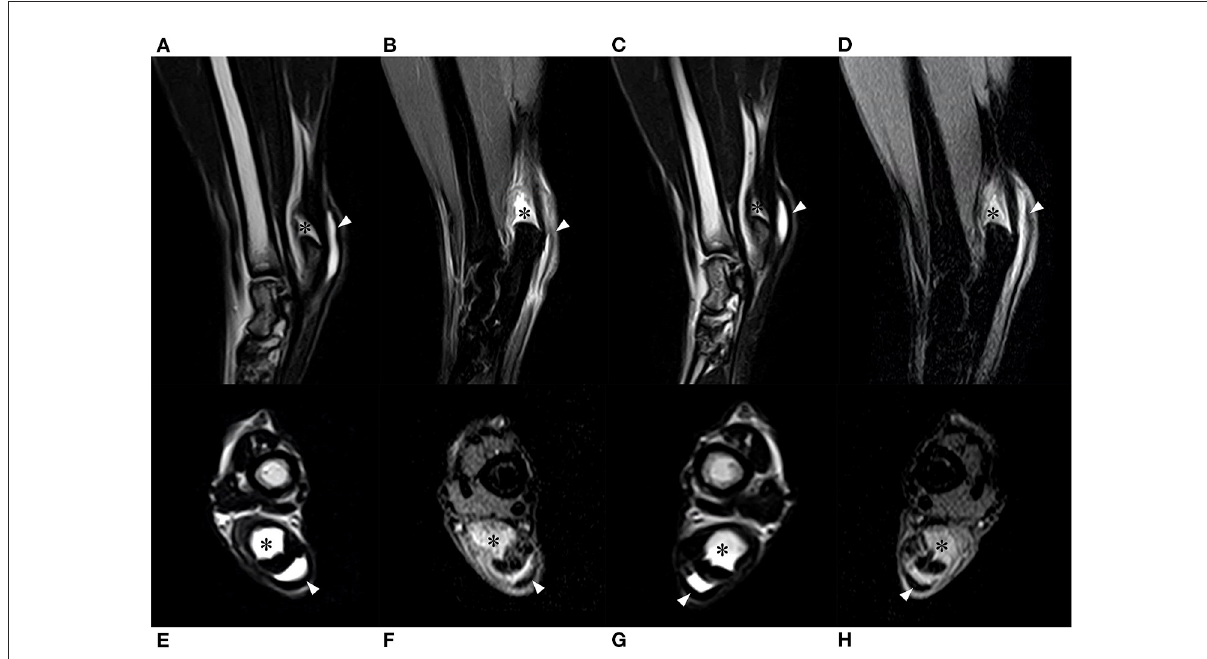
FIGURE3 Magnetic resonance imaging. (A) T2-weighted sagittal image of the right tarsal joint. (B) Postcontrast fat saturated proton density-weighted sagittal image of the right tarsal joint. (C) T2-weighted sagittal image of the left tarsal joint. (D) Postcontrast fat saturated proton density-weighted sagittal image of the left tarsal joint. (E) T2-weighted coronal image of the right tarsal joint. (F) Postcontrast fat saturated proton density-weighted coronal image of the right tarsal joint. (G) T2-weighted coronal image of the left tarsal joint. (H) Postcontrast fat saturated proton density-weighted coronal image of the left tarsal joint. The gastrocnemius calcaneal bursa (asterisk) and intertendinous bursa (arrowhead) were identified as hyperintense regions. Components of the calcaneal tendon such as common tendon, gastrocnemius tendon, and superficial digital flexor tendon were intact (identified as hypointense